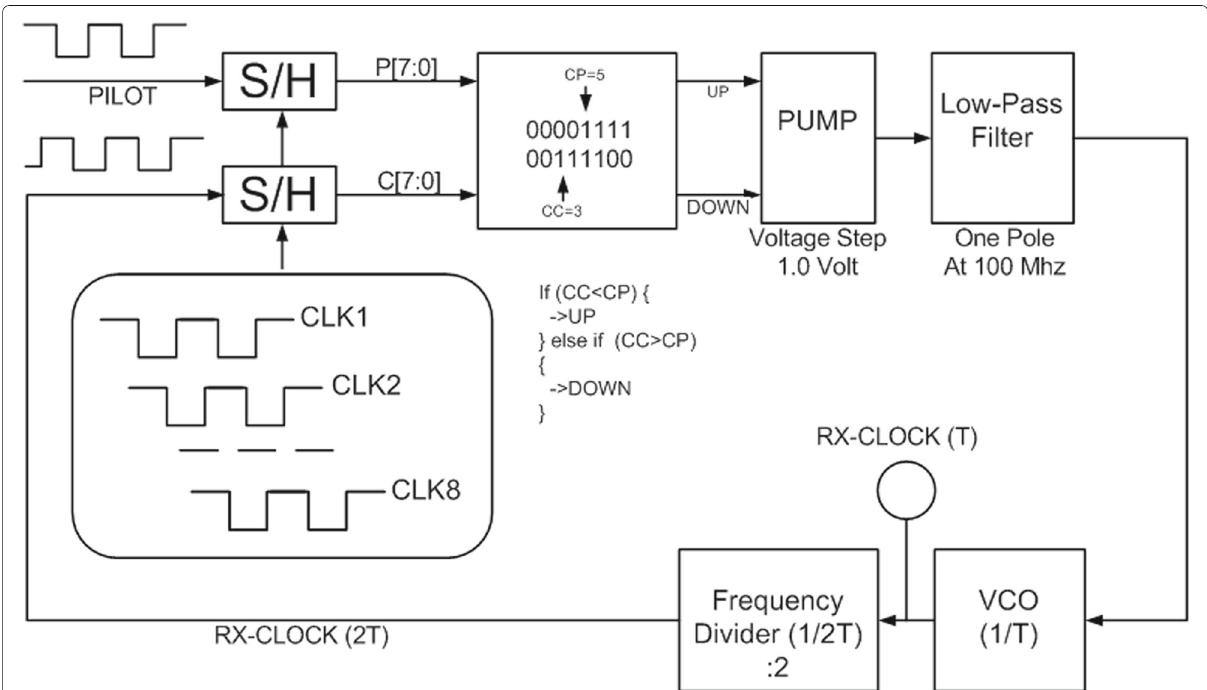
Fig. 11 The timing recovery subsystem based on a digital closed loop. This architecture uses a phase detector that samples the pilot sequence and the RX clock. The leading one in the 8-bit registers measures the current jitter between these two waveforms